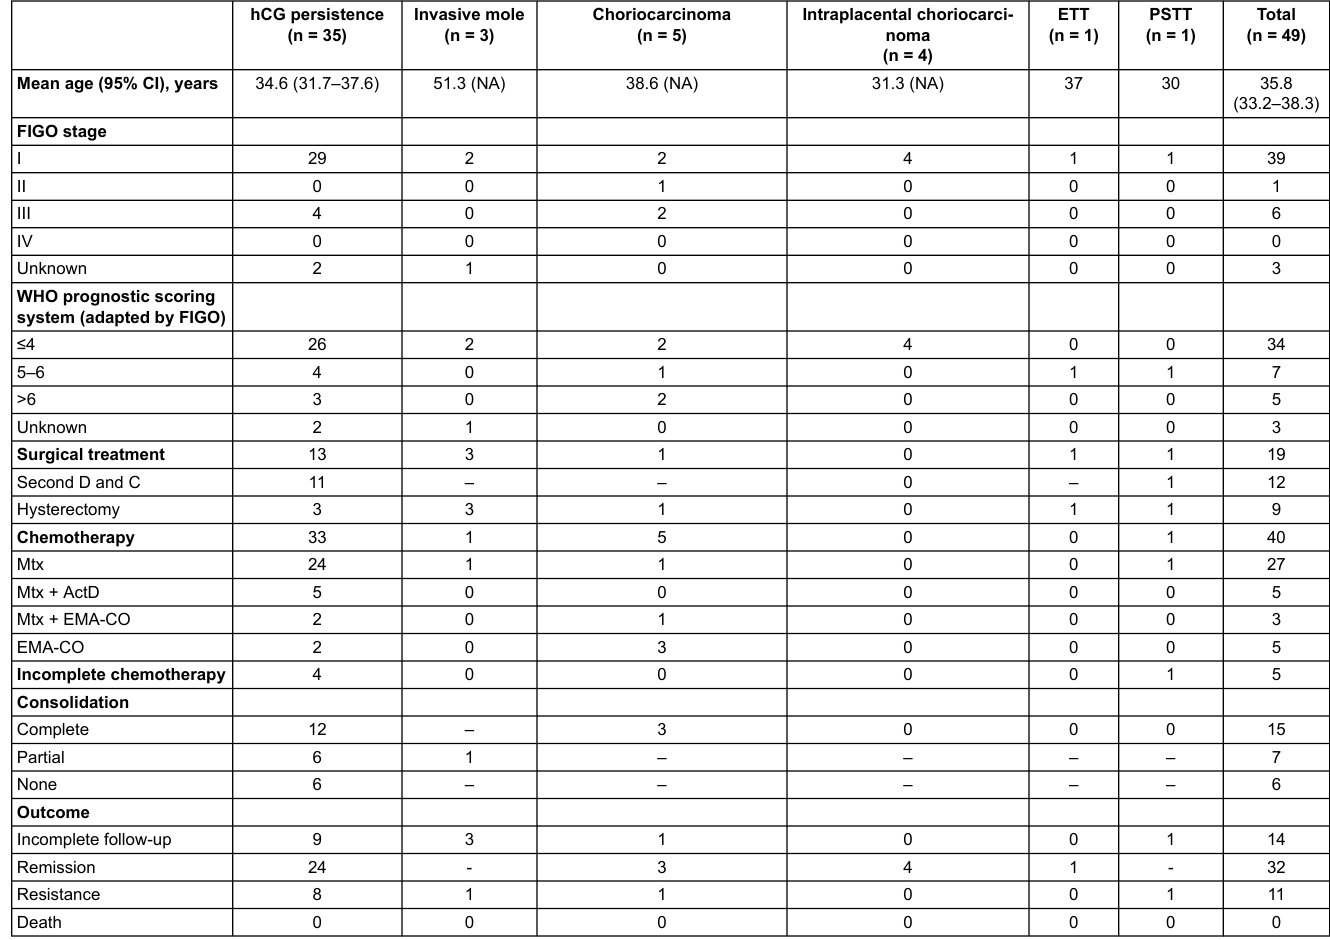
Table 3: Gestational trophoblastic neoplasia.